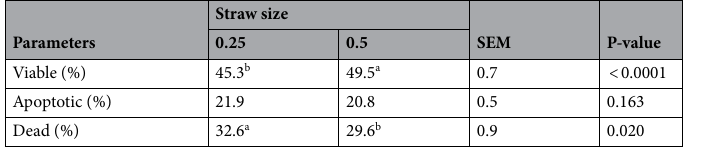
Table 6. Effect of straw size on viability and apoptotic-like changes and dead of thawed rooster sperm. Different superscripts letters within row are significantly different (P < 0.05).